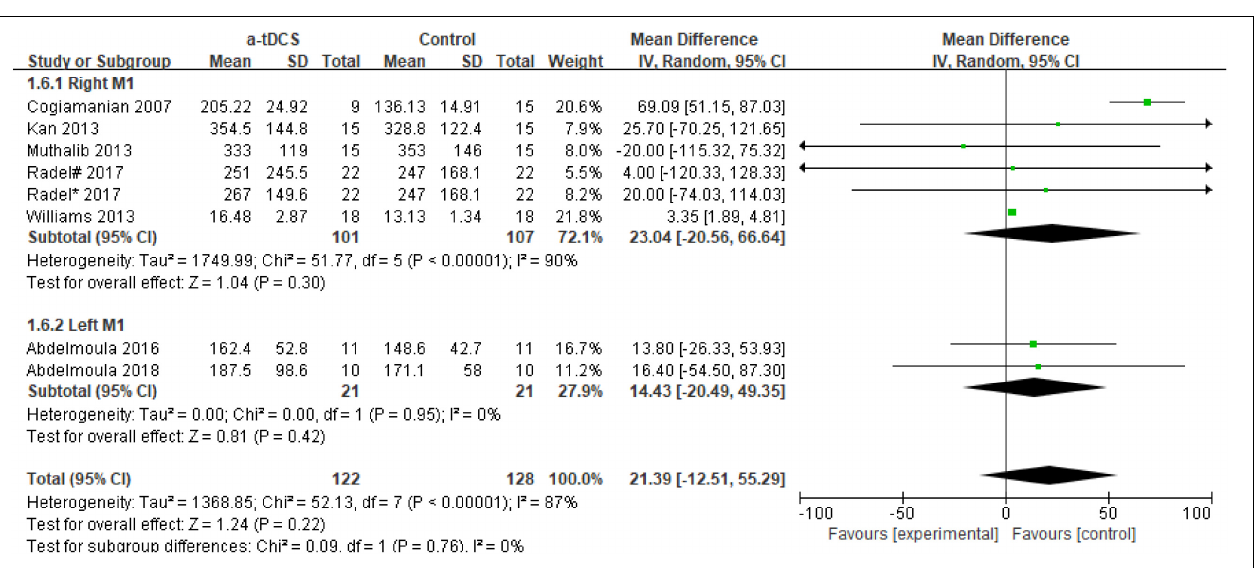
FIGURE 3 | Forest plot for the effect of a-tDCS on enhancing upper limb muscle endurance.